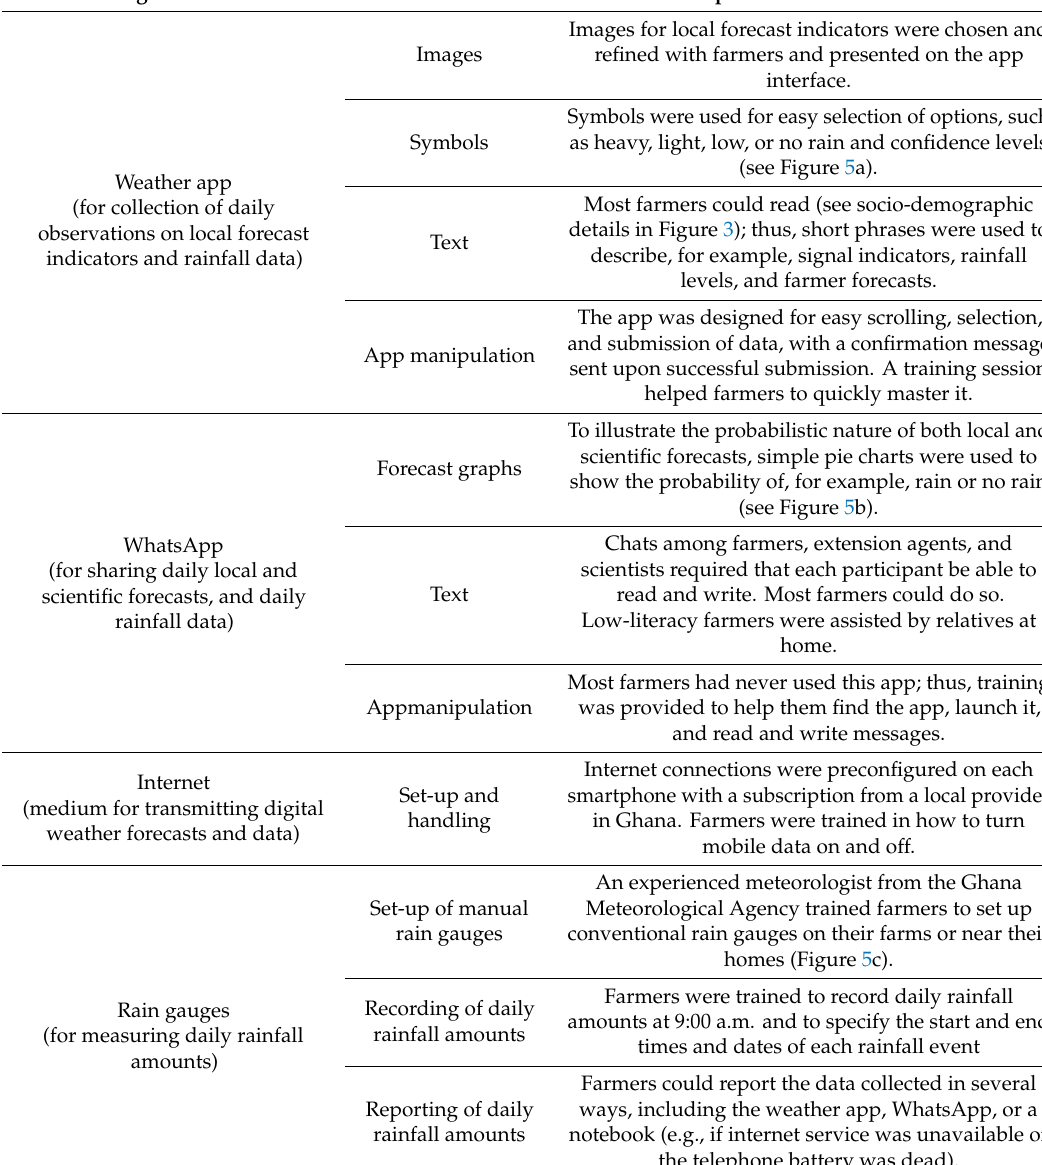
Table 2. Design aspects considered in coproduction of ICT-based digital and rain monitoring